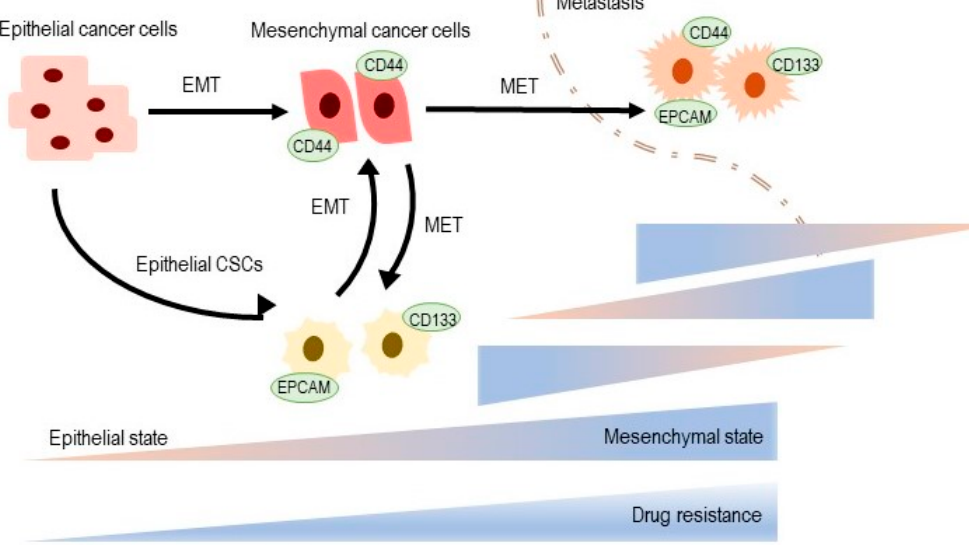
Figure 1. The epithelial–mesenchymal transformation (EMT) and cancer stem cells (CSC) at the crossroads towards drug resistance [68,69]. CSC subpopulations show EMT phenotypes. See text for details. MET: Mesenchymal-epithelial transformation.